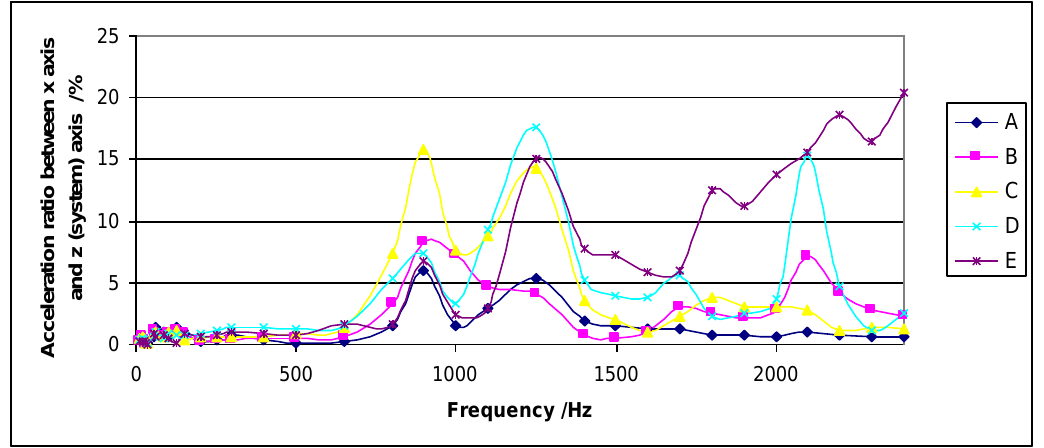
Figure 6. Ratio between the acceleration measured in the x axis and the acceleration measured in the z axis (system axis) versus excitation frequency for different spots on the measurement system: Upper part of the loading mass (A), lower part of the loading mass (B), mass-sensor coupling (C), sensor surface (D) and shaker upper surface (E). The sensor type is Interface 1610 and the loading mass is 2 kg.